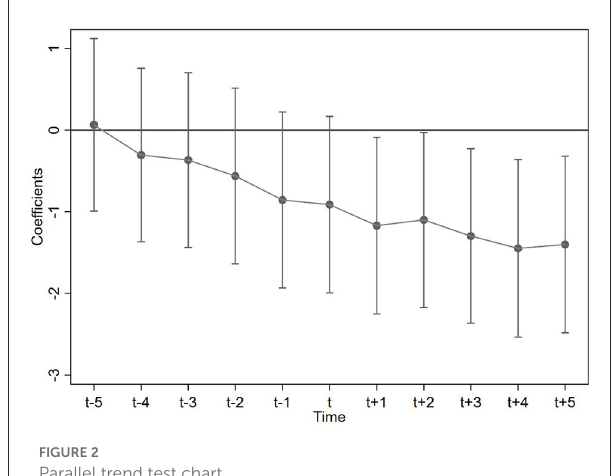
FIGURE2 Parallel trend test chart.